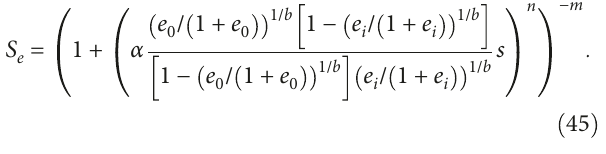
Figure 5: 15 bar pressure